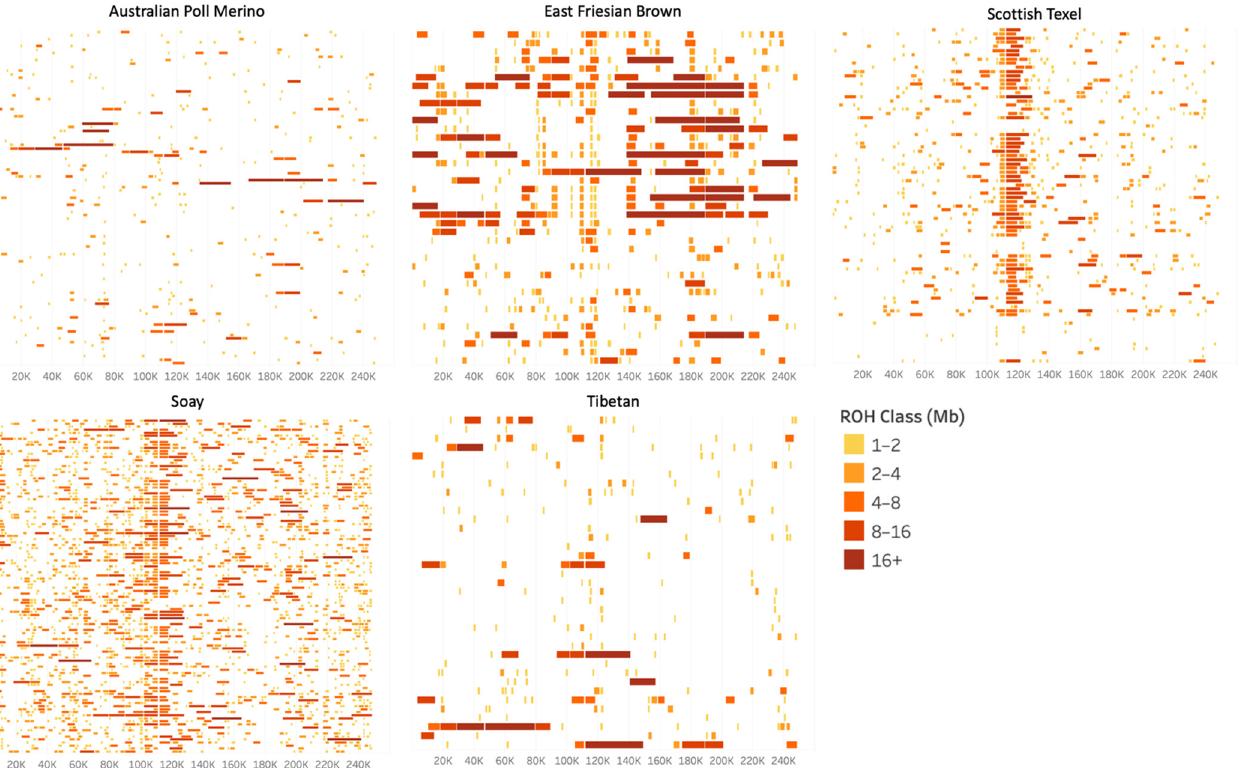
Figure 3. Distribution of ROH on chromosome OAR2 of five sheep populations, where each row represents an individual and the x-axis represents the position of runs in kb on the chromosome. The color scale represents the length of the runs in Mb, divided into five classes (1–2, 2–4, 4–8, 8–16, and >16 Mb). The results for all the other populations are presented in the Supplementary Material (File S1).